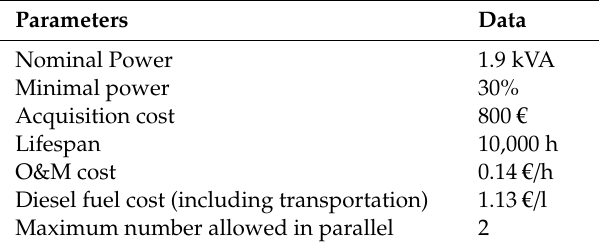
Table 8. Diesel generator considered in the